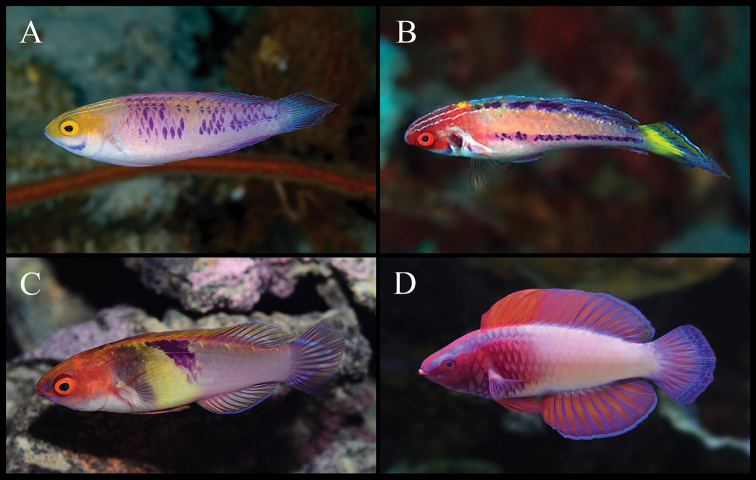
A selection of Cirrhilabrus species from the western Indian Ocean group of the Cirrhilabrusjordani complex ACirrhilabruswakanda sp. nov., in situ photograph from the east coast of Zanzibar, Africa BCirrhilabrusblatteus, in situ photograph from the Red Sea, off the coast of Eilat; C: Cirrhilabrussanguineus, aquarium photograph of a specimen from Mauritius DCirrhilabrusrubrisquamis, aquarium photograph of a specimen from the Maldives. Photographs by L.A. Rocha (A); E. Brokovich (B), and Y.K. Tea (C, D).